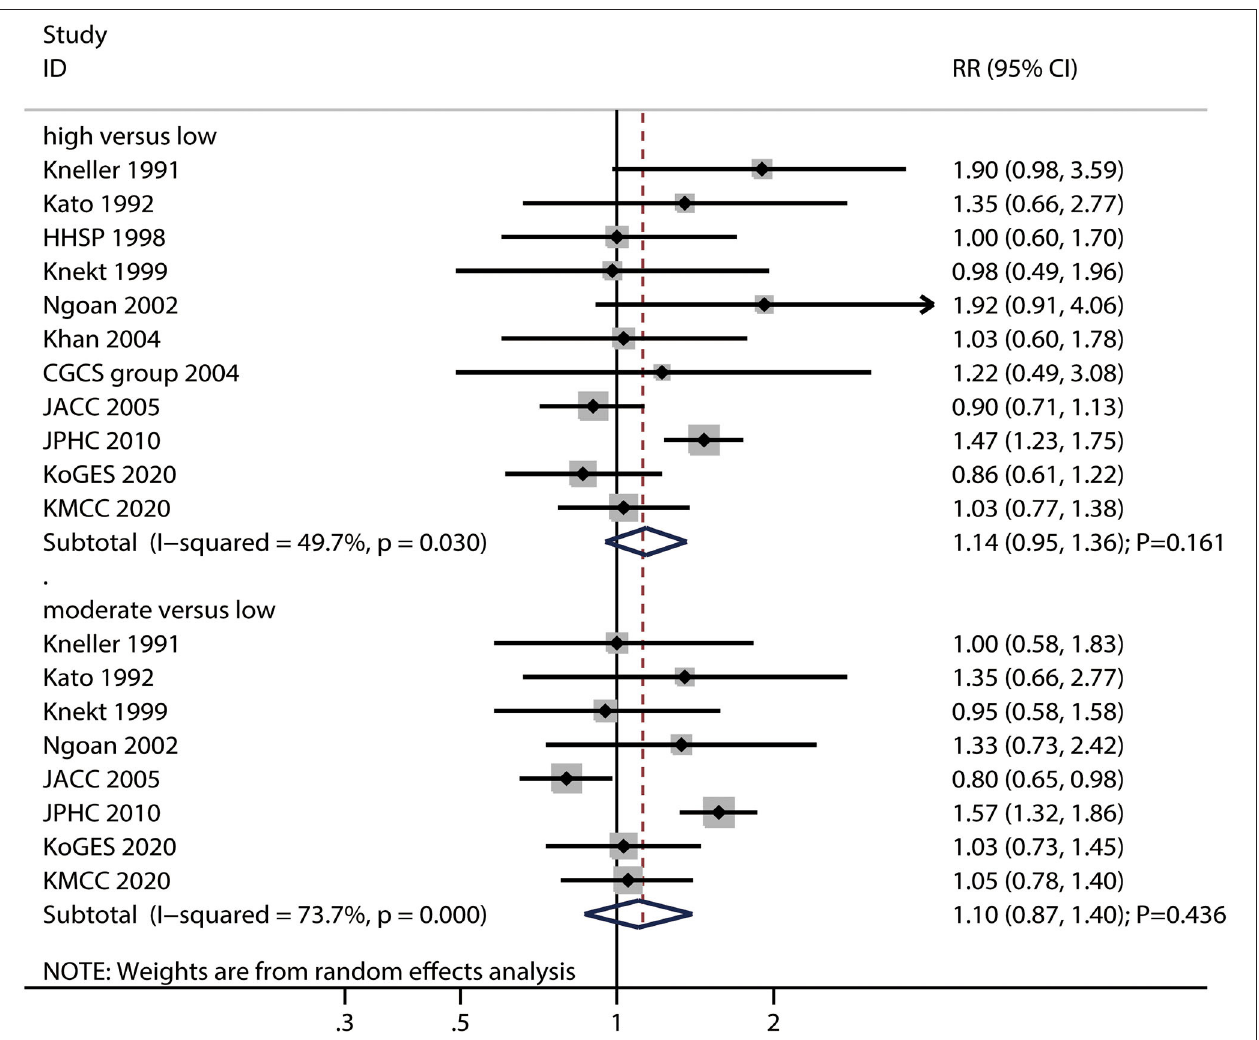
FIGURE 4 | Association between high or moderate salted fish intake and subsequent gastric cancer